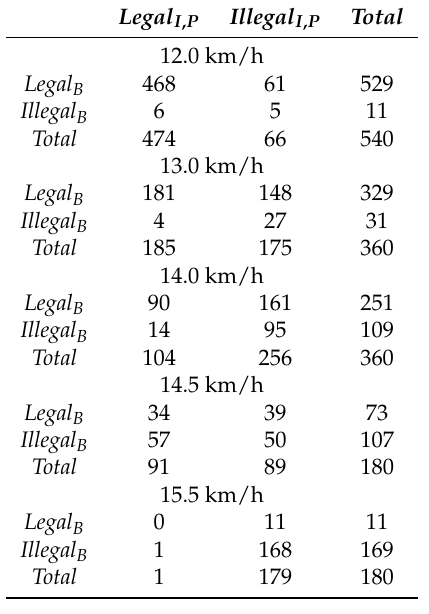
Table A3. Confusion matrices for the step sequence binary classification, based on Lee’s (left, subscript Lee ) and proposed (right, subscript P ) approaches. Legal B and Illegal B refer, respectively, to “legal” and “illegal” steps as classified from camera data. Legal I,Lee and Illegal I,Lee refer respectively to “legal” and “illegal” steps as classified from inertial data, following the Lee’s approach. Legal I,P and Illegal I,P refer, respectively, to “legal” and “illegal” steps as classified from inertial data, following the proposed approach.